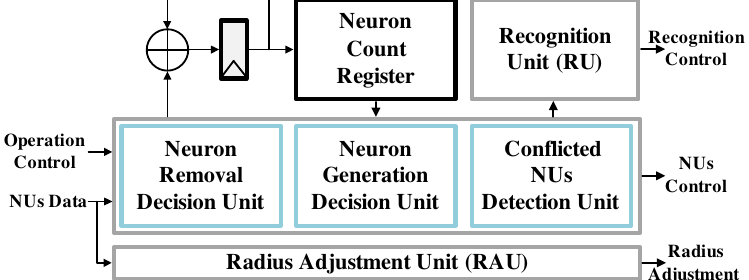
Figure 7. Block diagram of the network control unit (NCU).